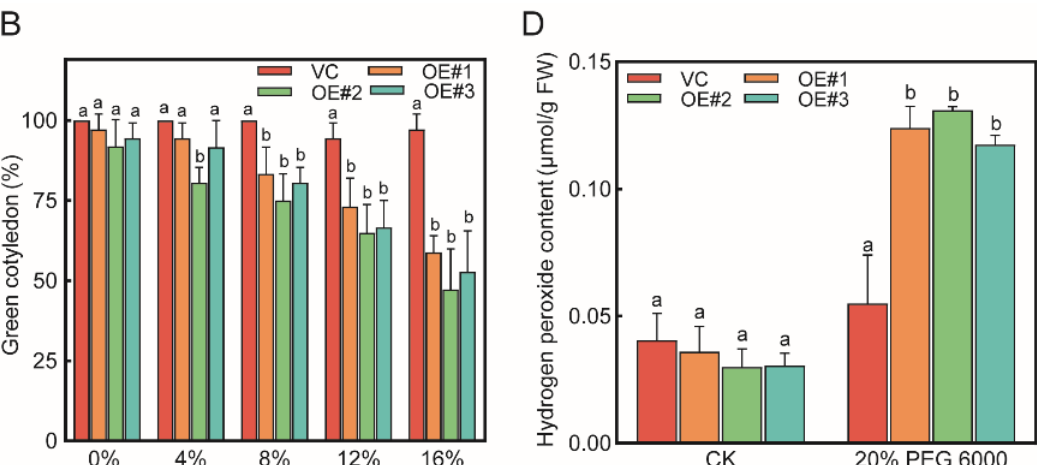
Figure 5. Response of RcTINY2 -OE Arabidopsis plants to drought stress. ( A ) Differential seed germination response between RcTINY2 -OE and VC plants on PEG-treated (0, 4%, 8%, 12% and 16%) MS agar plates. All photographs were taken ten days after germination; ( B ) Green cotyledon rates of VC and RcTINY2 -OEs in response to PEG treatment. All data are the mean ± SD from five independently conducted experiments ( n = 16–20); ( C ) Ten-day-old VC and RcTINY2 -OE seedlings were stained with DAB (1 mg/mL) and NBT (1 mg/mL) for 12 h after PEG treatment for 30 min; ( D ) Accumulation of H 2 O 2 in VC and RcTINY2 -OE plants after 30 min of PEG treatment. All data are the mean ± SD for three biological replicates. LSD tests were used to determine statistically significant differences ( p < 0.05) which are indicated by different letters.